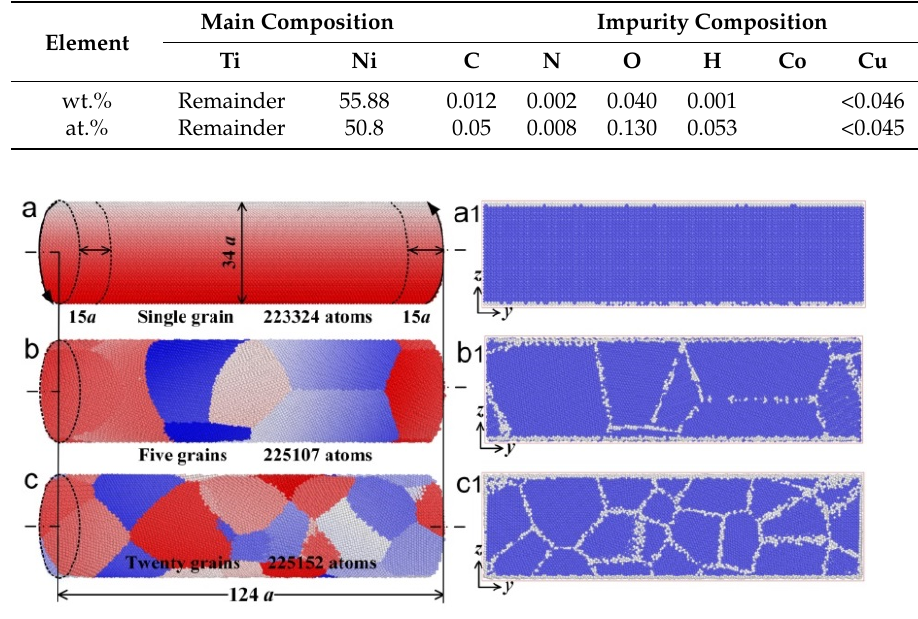
Figure 1. The Ni 50.8 Ti cylinder models and the longitudinal section slices. ( a ) Single crystal cylinder model, containing 223,324 atoms; ( b ) Polycrystalline cylinder model, containing 5 grains and 225,107 atoms; ( c ) Polycrystalline cylinder model, containing 20 grains and 225,152 atoms; ( a1 – c1 ) The longitudinal section slices of the model shown in Figure 1a–c, respectively. Table 2. The diameter D , average grain size d , and scale parameter N in different NiTi